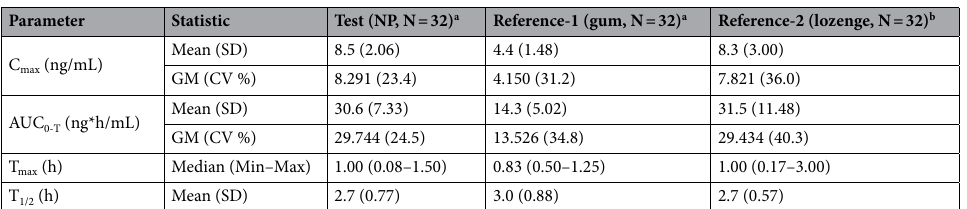
Table 2. Plasma nicotine PK parameters measured among adult smokers after single oral product use of three nicotine products under fasting conditions. CV coefficient of variation, GM geometric mean, Max maximum, Min minimum, SD standard deviation. a N = 31 for T 1/2 (the terminal part of the log concentration–time curve could not be adequately estimated for 1 participant). b N = 29 for T 1/2 ; (the terminal portion of the log concentration–time curve could not be adequately estimated for 3